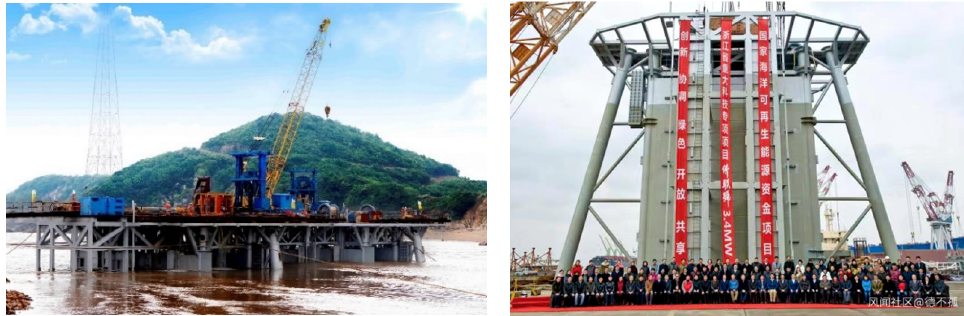
Figure 29. The assembly platform of the “3.4 MW LHD Modular Large-scale Tidal Power Generating Units”. Reproduced from [77,78].